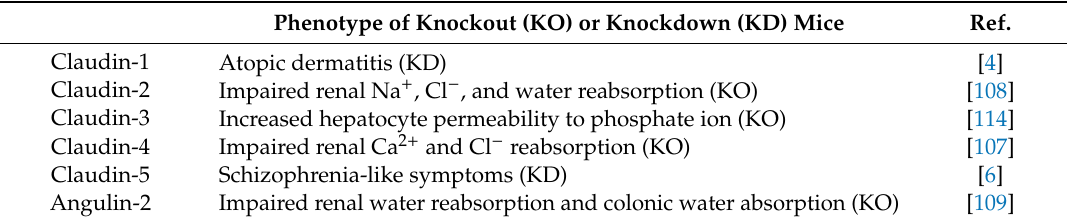
Table 3. Phenotypes of representative claudin- or angulin-knockout or -knockdown mice. Phenotype of Knockout (KO) or Knockdown (KD) Mice